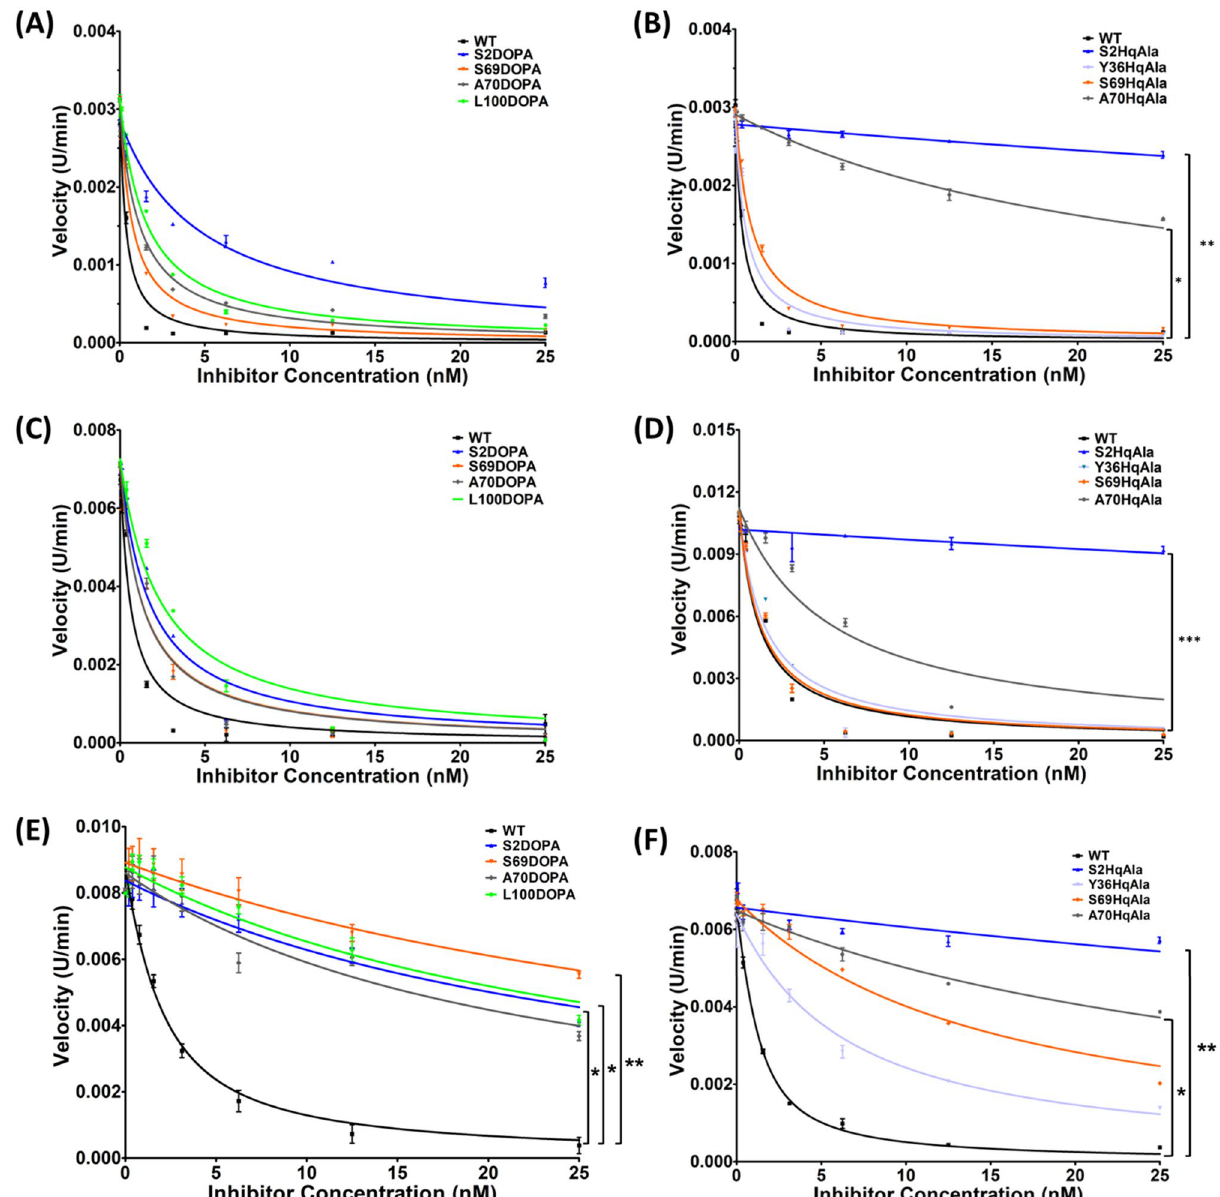
Figure 5. MMP inhibitory activity of N-TIMP2 variants. MMP-2 ACT ( A , B ), MMP-9 CAT ( C , D ) and MMP-14 CAT ( E , F ) were incubated with N-TIMP2, N-TIMP2-DOPA variants ( A , C , E ) or N-TIMP2-HqAla ( B , D , F ) variants at various concentrations. Cleavage of the chromogenic substrate (100 µM) was measured over time, and the velocity (slope) of the reaction as a function of inhibitor concentration was fitted to Morrison’s equation (Eq. 1) to obtain the inhibition constant K i . Statistical analysis for the comparison of N-TIMP2 to N-TIMP2-DOPA and N-TIMP2-HqAla variants was performed by Student’s t-test; *P < 0.05, **P < 0.01. Error bars represent SEM; n =